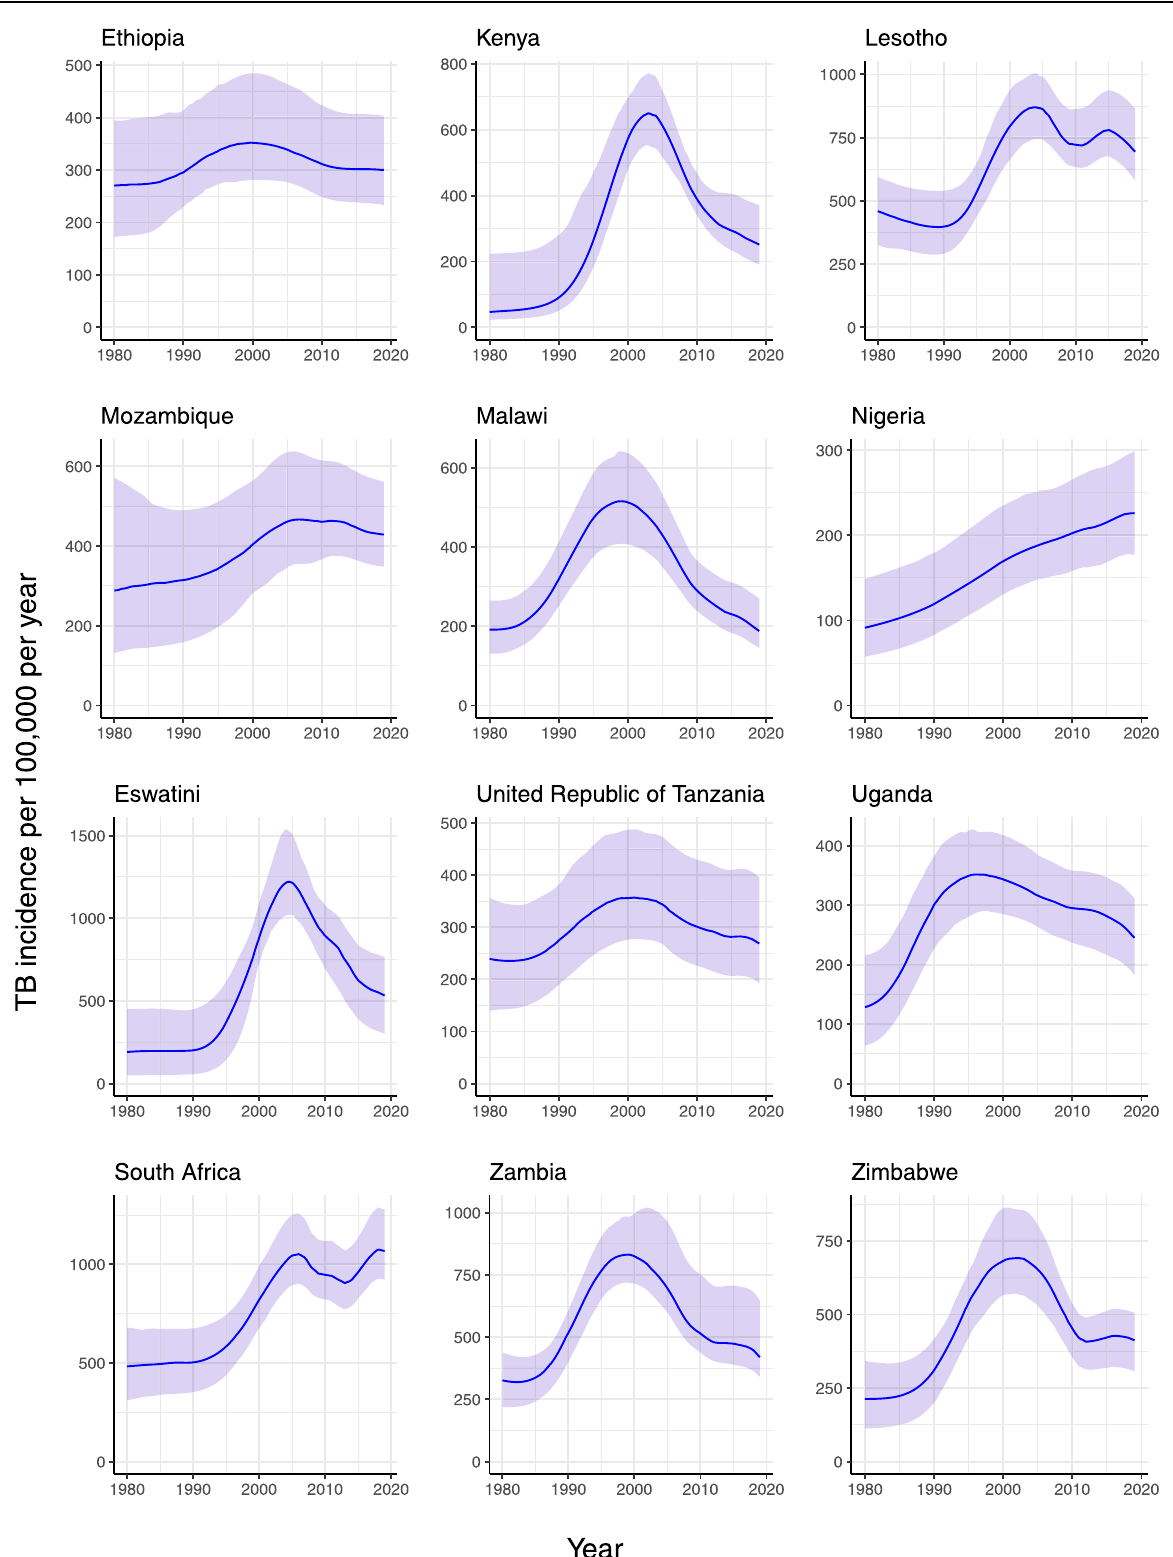
Fig. 3 | Per capita TB incidence estimated for 12 African countries, 1980 – 2019. Line=median, ribbon=95% credible interval [CrI]. All medians and CrIs are based